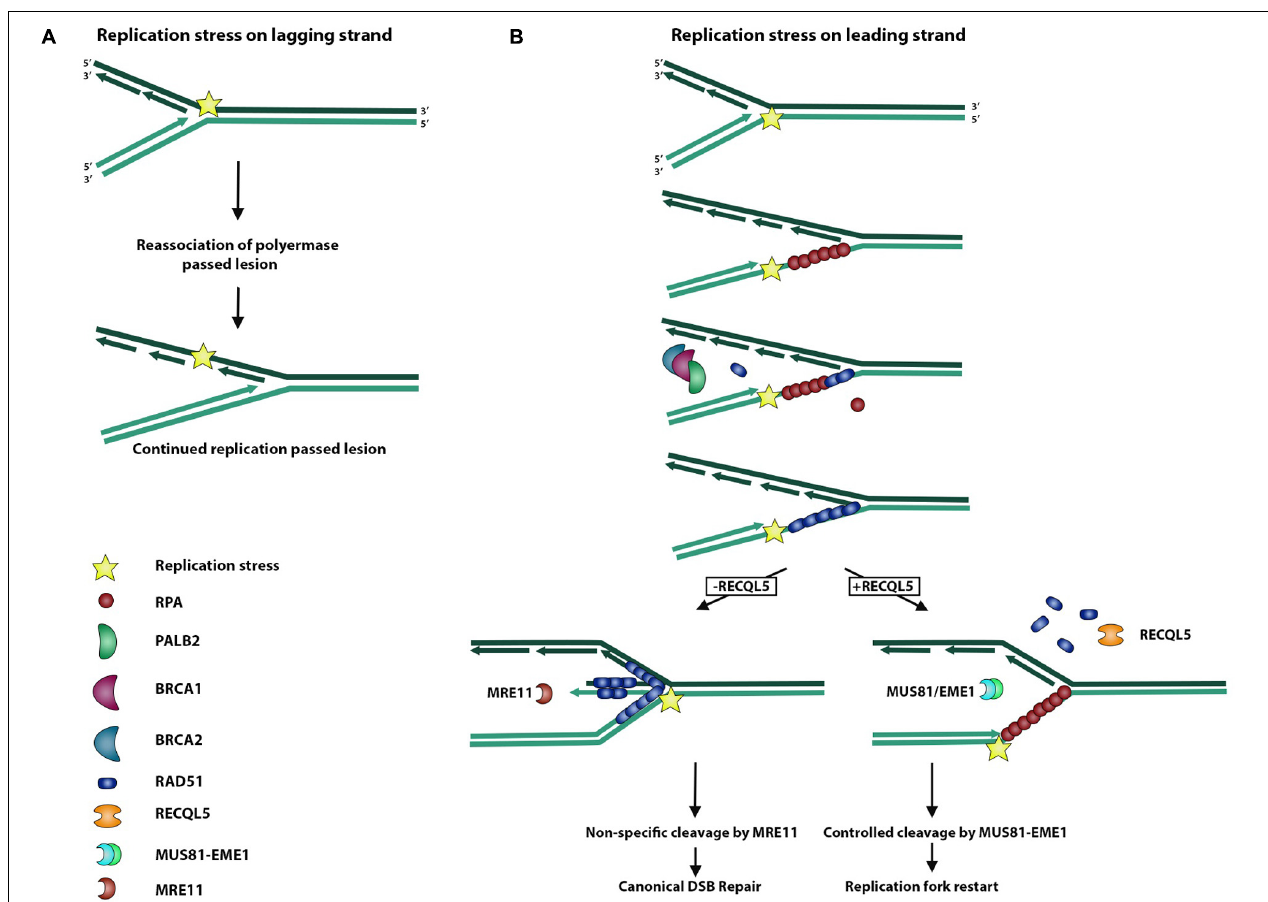
FIGURE 3 | Role of RECQL5 in replication stress response. Replisome can encounter a replication stress-inducing lesion on either a lagging or leading strand. (A) When the replisome encounters a lesion on a lagging strand, DNA polymerase is able to bypass the lesion by dissociating from the Okazaki fragment and reassociating to form a new fragment ahead of the lesion. (B) Replisome encountering a lesion on a leading strand may lead to replication fork uncoupling, whereby the polymerase is stalled and dissociated from the replication helicase, which continues unwinding DNA and exposing ssDNA. Exposed ssDNA and simultaneous depletion of free RPA serve to activate ATR signaling of the replication stress response and recruit BRCA1/2 and PALB2 to begin exchange of RPA for RAD51. RAD51 actively promotes reversal of the replication fork and formation of a regressed arm whereby newly synthesized DNA strands anneal to each other, allowing for non-specific cleavage by the MRE11 endonuclease and subsequent canonical DSB repair. In the presence of RECQL5, RAD51 is removed from ssDNA, and the MUS81/EME1 endonuclease complex is recruited to allow controlled cleavage and replication fork